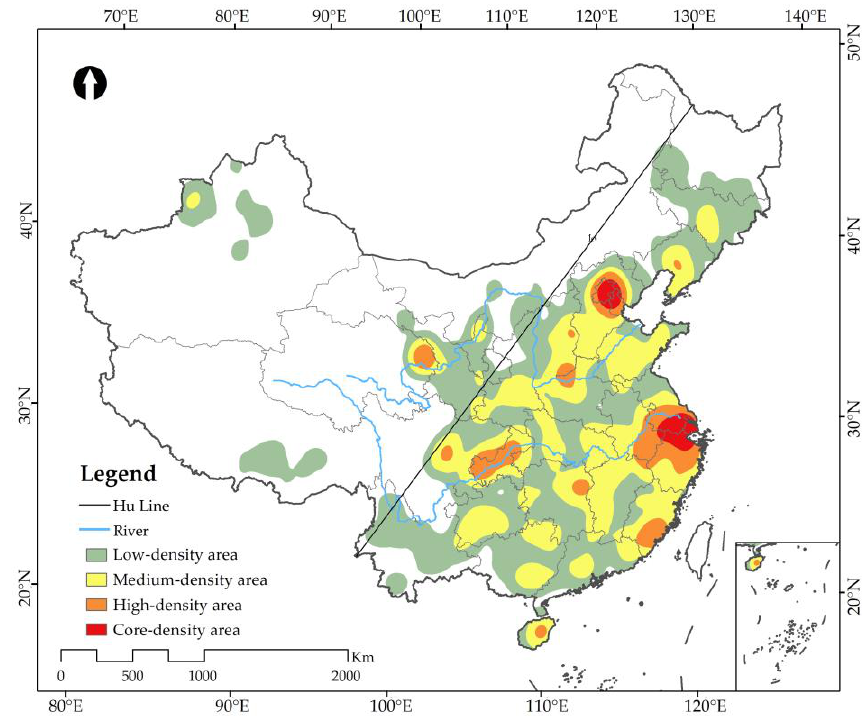
Figure 5. Spatial kernel density distribution of beautiful leisure villages in China.